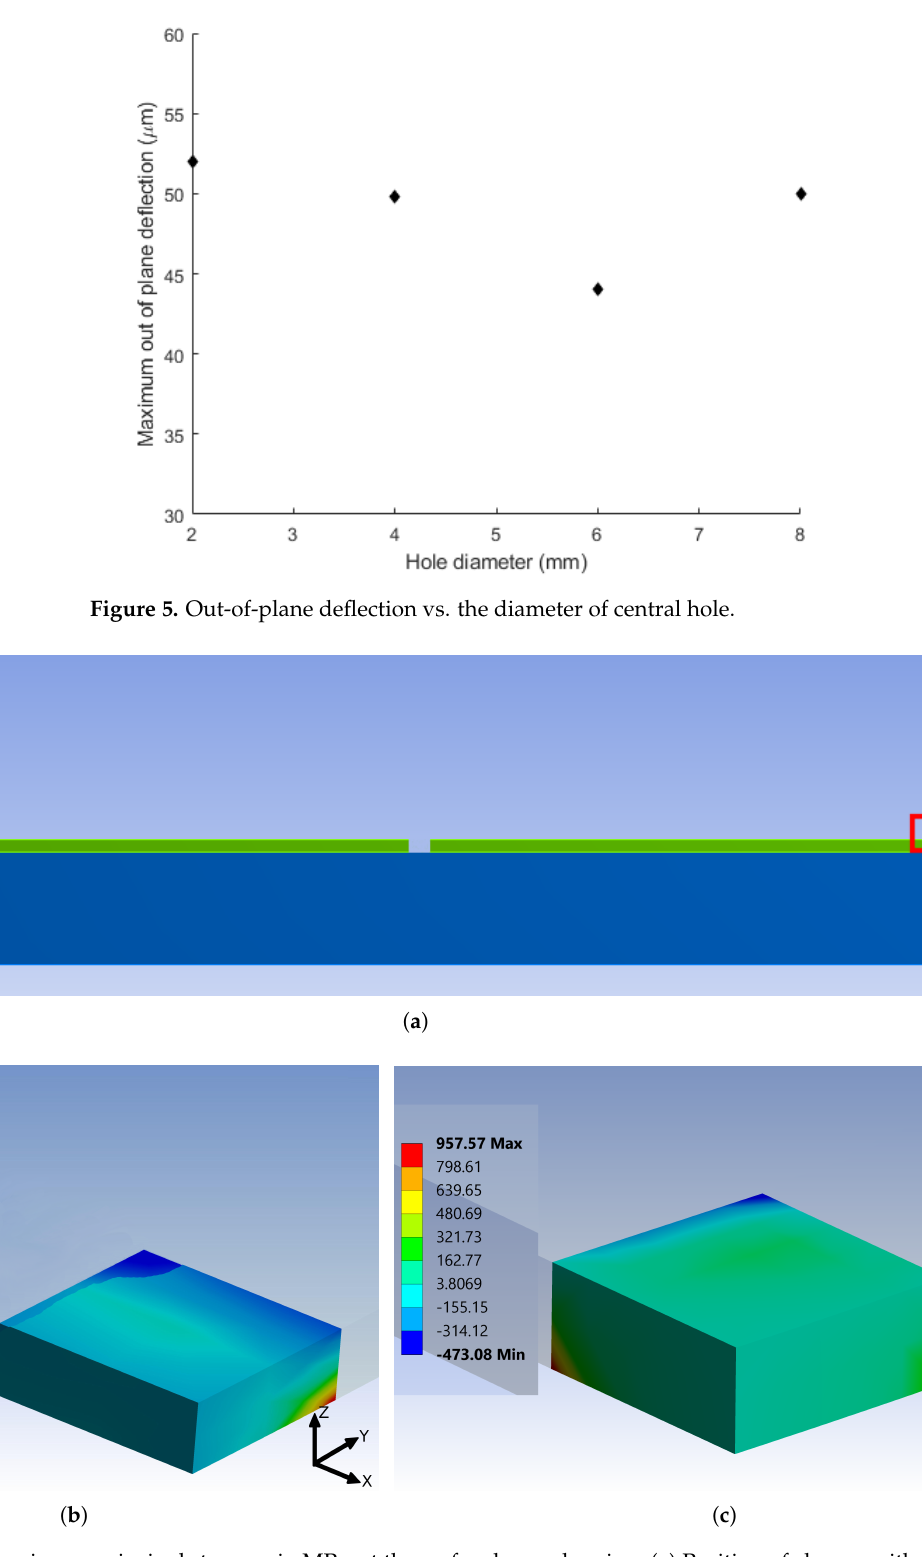
Figure 6. Map of maximum principal stresses, in MPa, at the wafer clamped region. ( a ) Position of clamps with respect to the central hole; ( b ) Wafers without central hole; ( c ) Wafers with central hole (6 mm